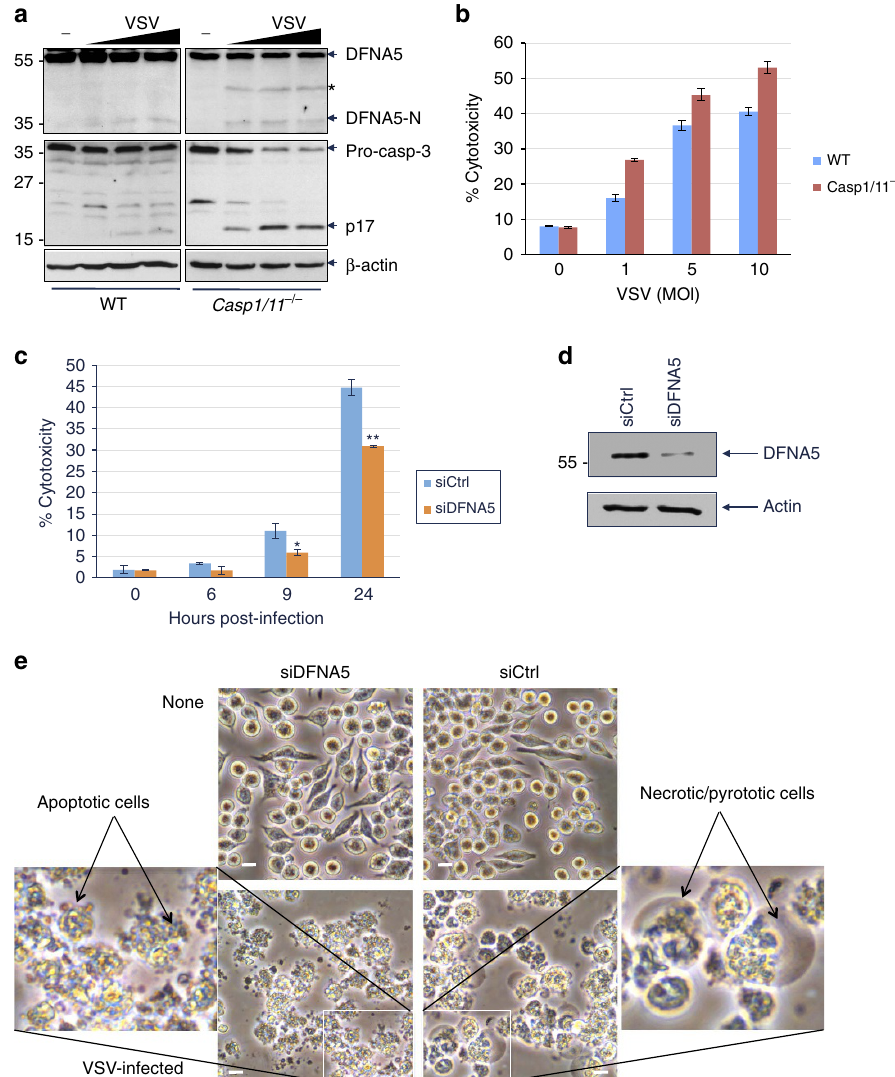
Figure 6 | Activation of DFNA5 downstream of viral infection in macrophages. ( a ) Immunoblots of DFNA5 in cell lysates from uninfected ( (cid:2) ) or VSV-infected (1, 5, 10 MOI) WT (left) or casp-1/11 dKO (right) immortalized BMDMs. The lower panels show caspase-3 and b -actin in the same cell lysates. Asterisk indicates non-specific band. ( b , c ) Cytotoxicity of VSV as measured by LDH release in the culture supernatants of WTand casp-1/11 dKO BMDMs infected with VSV for 12h ( b ) ( n ¼ 3) or casp-1/11 dKO BMDMs transfected with control siRNA (siCtrl) or DFNA5 siRNA (siDFNA5) for 48h and then infected with VSV (1 MOI) for the indicated times ( c ). ( n ¼ 3) * P o 0.01, ** P o 0.001, Student’s t -test. ( d ) Immunoblots of DFNA5 in the control